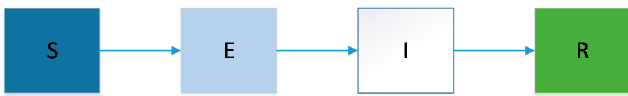
Figure 1. Susceptible–Exposed–Infectious–Recovered (SEIR) epidemic-dynamics model.